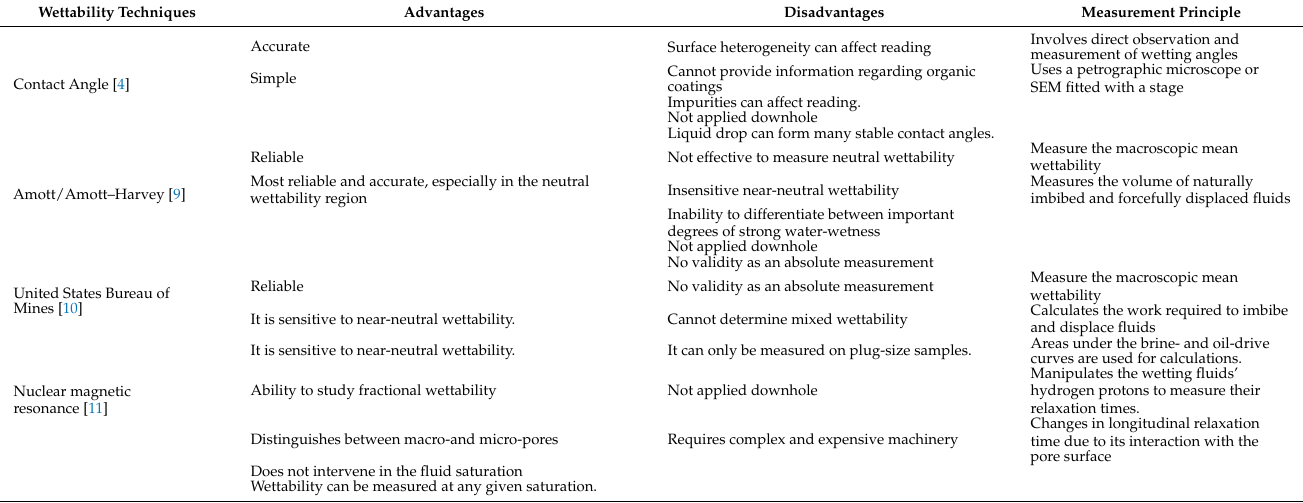
Table 1. Summary of the different quantitative wettability measurement techniques identifying key advantages, limitations, and